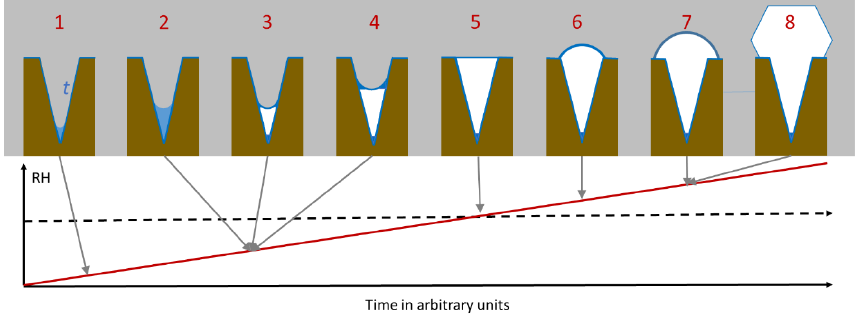
Figure 1. Pore condensation and freezing in conical or wedge-shaped pores (brown) assuming continuously increasing RH (red line). The pore is assumed to be covered with a quasi-liquid layer (QLL) of width t (darker blue) already at low RH. Free water (lighter blue) collects in pores and freezes to ice (white) that further grows within the pore. At ice saturation (dashed black horizontal line), the pore is completely filled with ice.